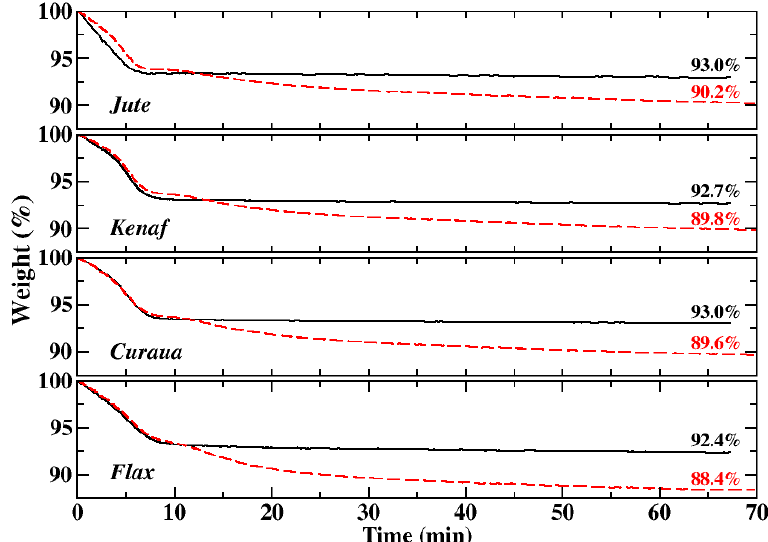
Figure 3. The isothermal TGA of jute, kenaf, curaua, and flax fibres during isothermal heating at 175 ◦ C (black lines) and 225 ◦ C (red dashed lines). Weights (%) after 1 h isothermal TGA run of the fibres are highlighted inside